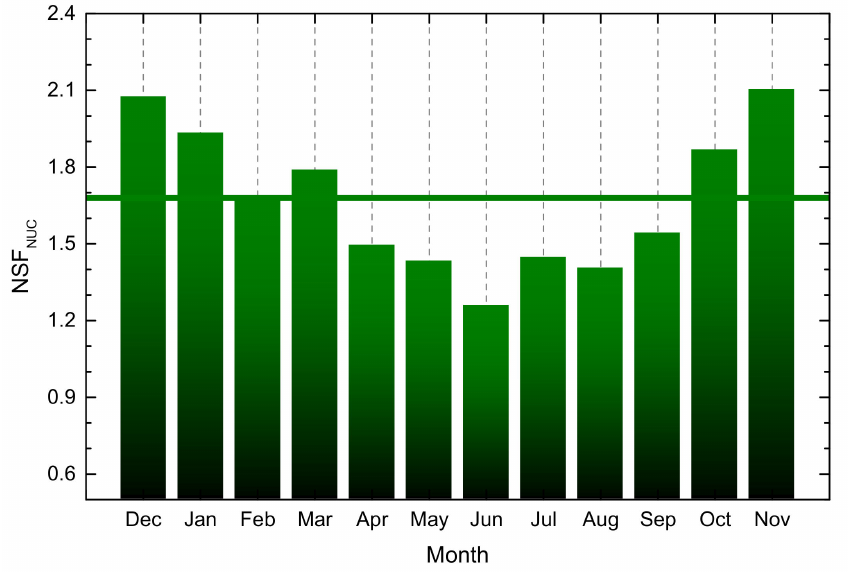
Figure 5. Distribution of the monthly mean nucleation strength factor on a nucleation day (NSF NUC ) averaged for 8 measurement years in the city center. The horizontal line indicates the overall